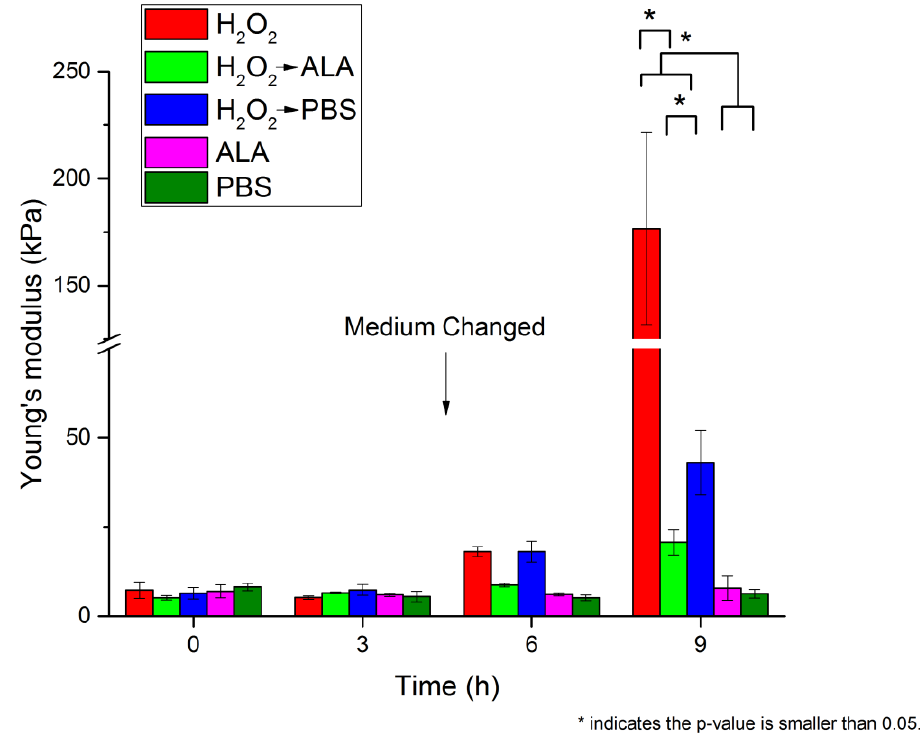
Figure 6. The OCE-estimated Young’s moduli for the lenses incubated with five different media. The data are presented at the intersample mean ± standard deviation (N = 3 for each group). The asterisks indicate statistical significance ( p < 0.05) determined by Student’s t -test. Table 1. Surface wave group velocities and Young’s moduli of the lenses incubated in different storage media. The error is the intersample standard deviation.